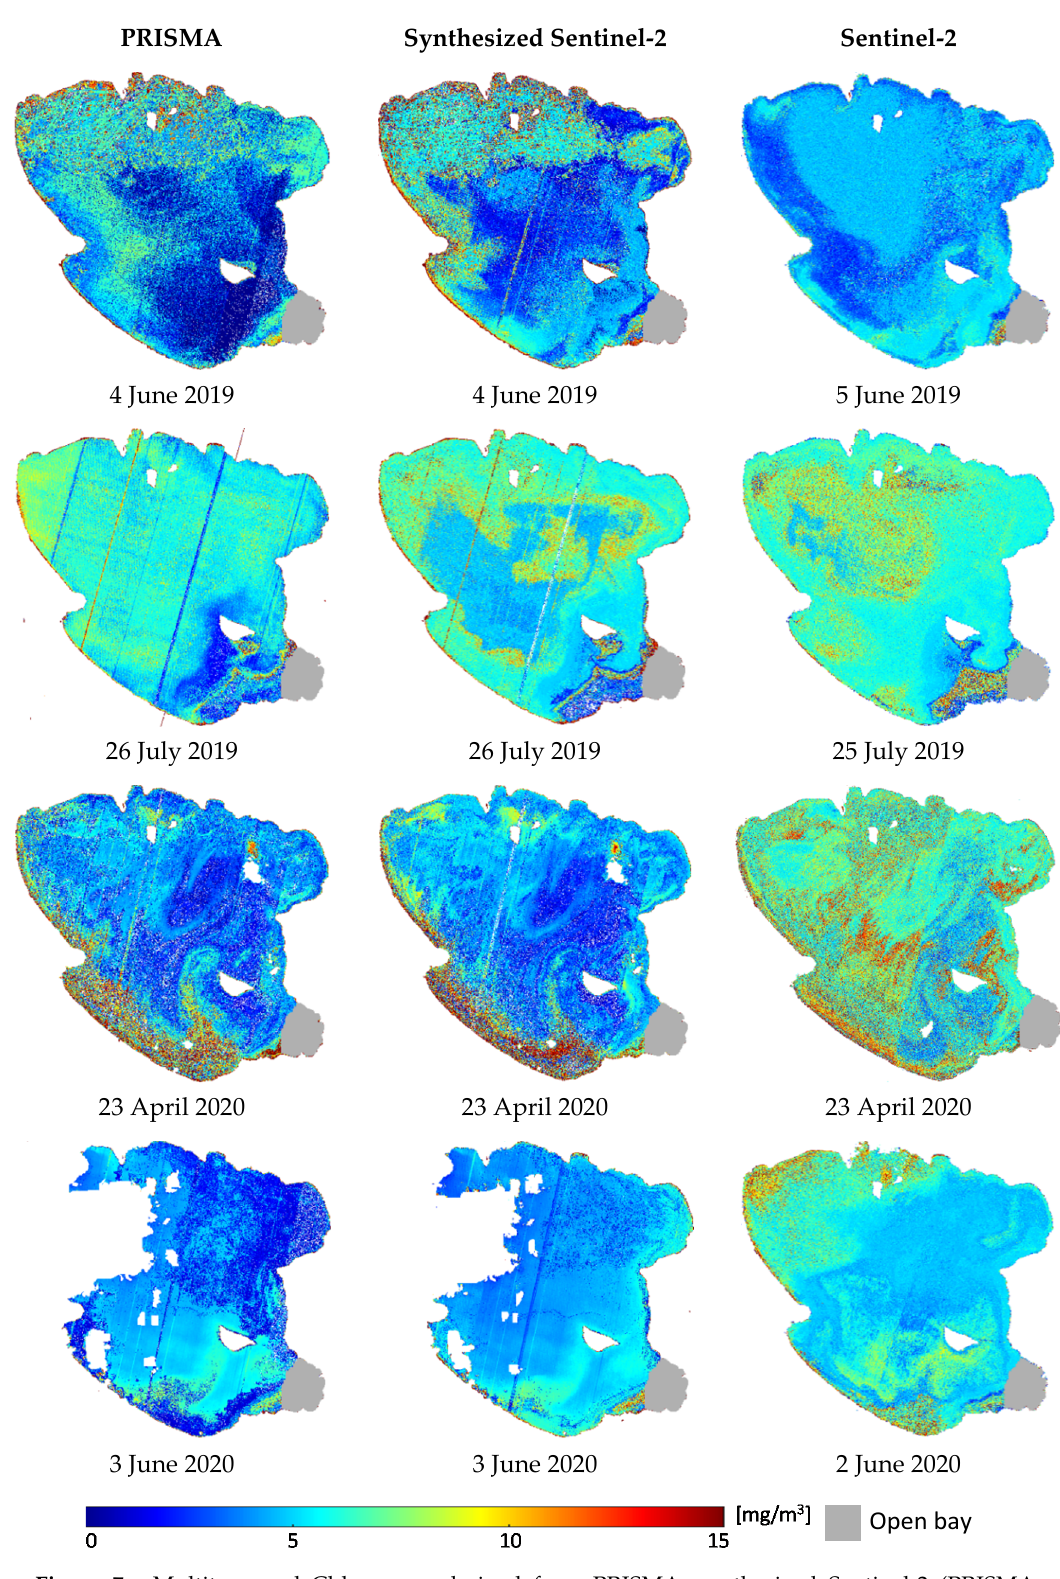
Figure 7. Multitemporal Chl-a maps derived from PRISMA, synthesized Sentinel-2 (PRISMA resampled), and Sentinel-2 images. The missing data are related to the cloud cover.